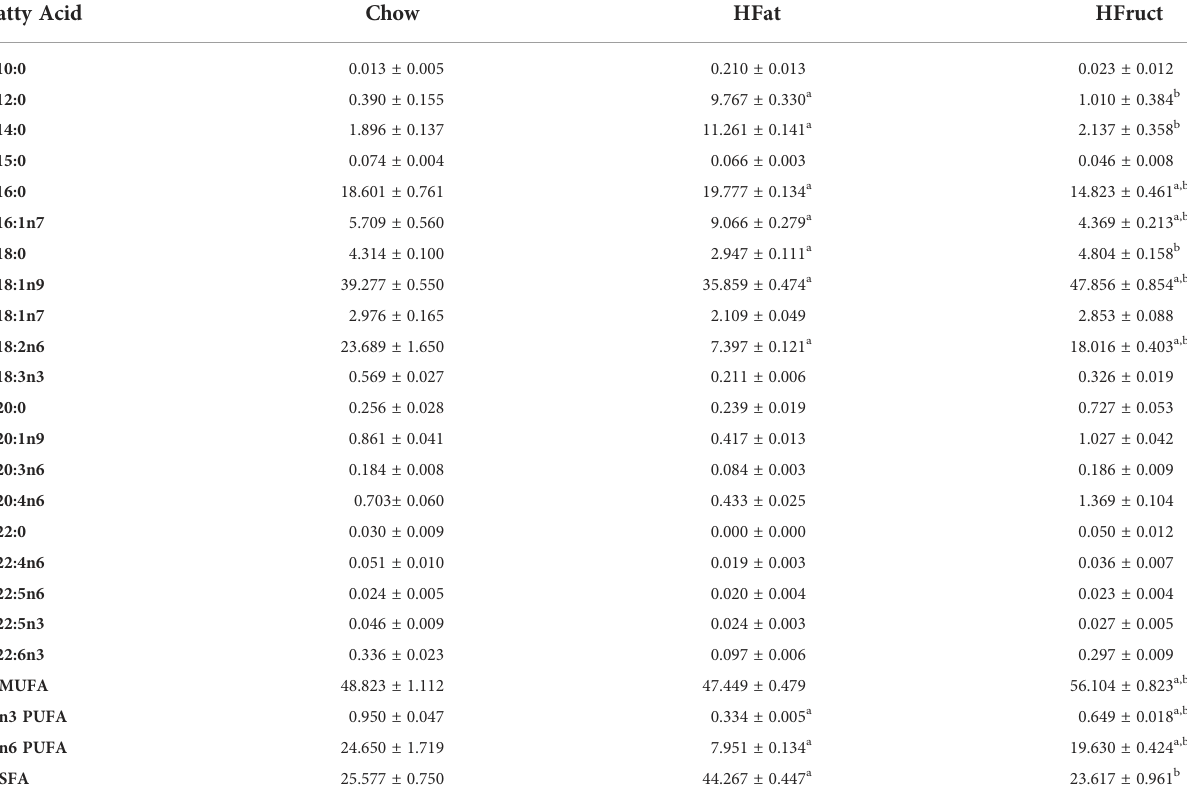
Values represent mean ± SEM for fi ve to seven mice per experimental group. a p<0.05 vs. Chow; b p<0.05 vs. HFat. Monounsaturated fatty acids (MUFAs) correspond to C16:1n7, C18:1n9, C18:1n7,andC20:1n9.n-3polyunsaturatedfattyacids(PUFA)correspondtoC18:3n3,C22:5n3,andC22:6n3;n-6PUFAcorrespondtoC18:2n6,C20:3n6,C20:4n6,C22:4n6,andC22:5n6. Saturated fatty acids (SFAs) correspond to C10:0, C12:0, C14:0, C15:0, C16:0, C18:0, C20:0, and